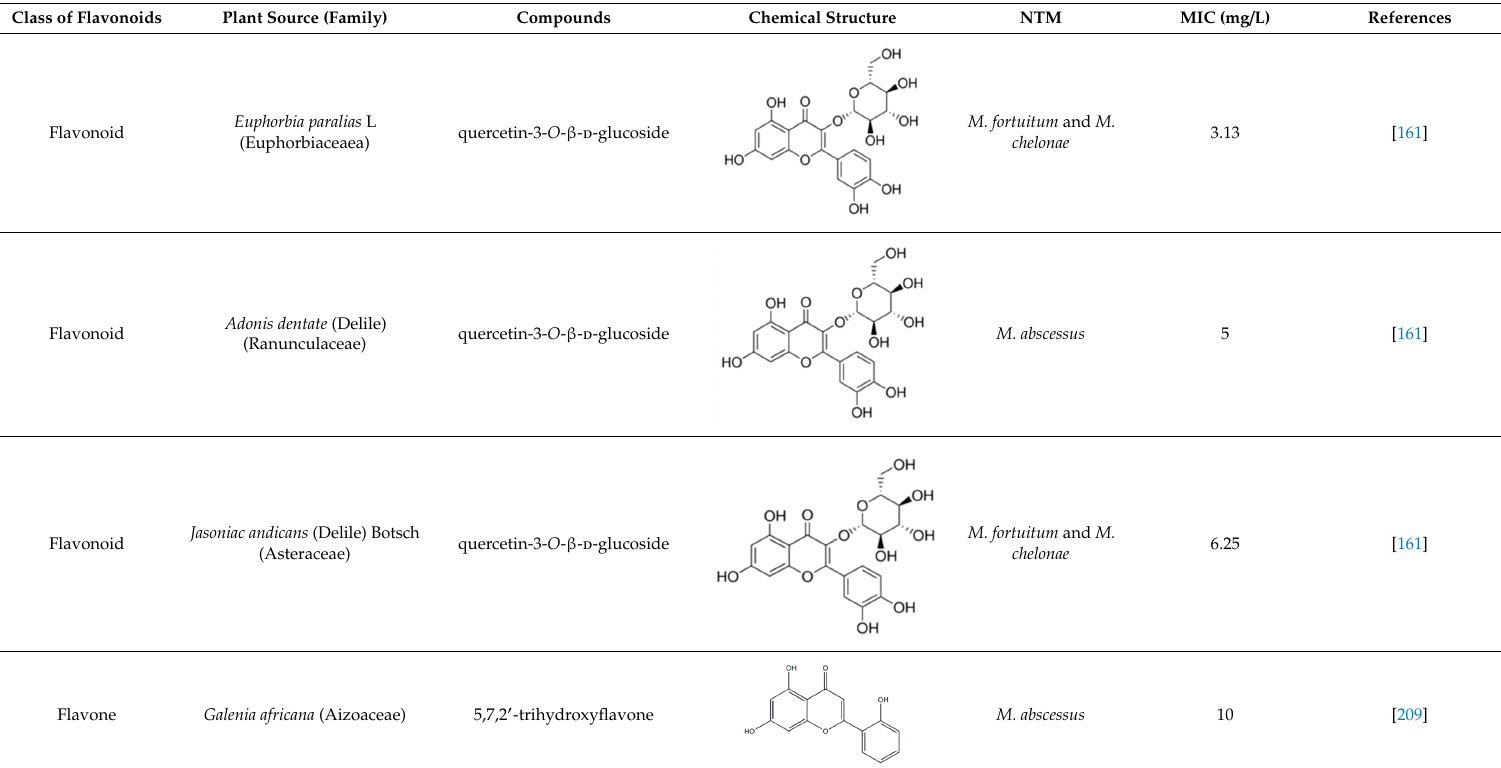
Table 3. Anti-nontuberculous mycobacterial effects of flavonoids.